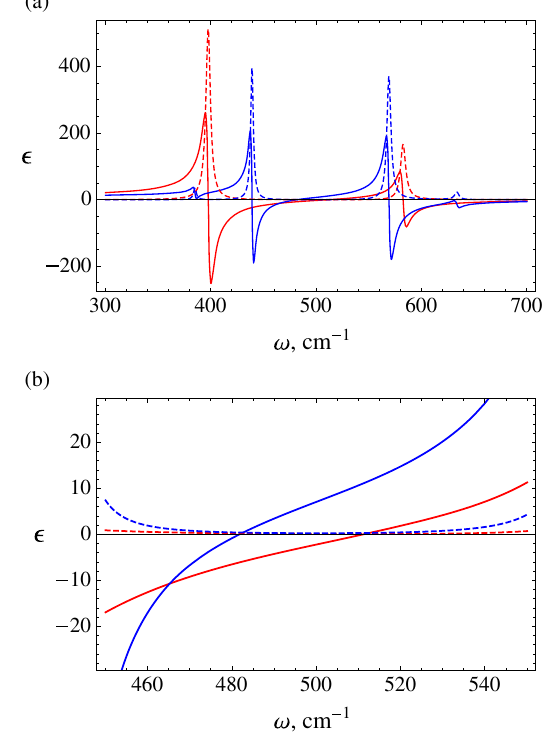
FIG. 8. Panel (a): the dielectric permittivity tensor of sapphire monocrystal in the Restrahlen band, from the measurements of Ref. [23]. Panel (b) shows the range near the free-space wave- length of 20 μ m that supports a low-loss hyperbolic band. Red and blue lines correspond, respectively, to the permittivities parallel and perpendicular to the C axis of the sapphire crystal. Real and imaginary parts of the permittivity are represented by solid and dotted